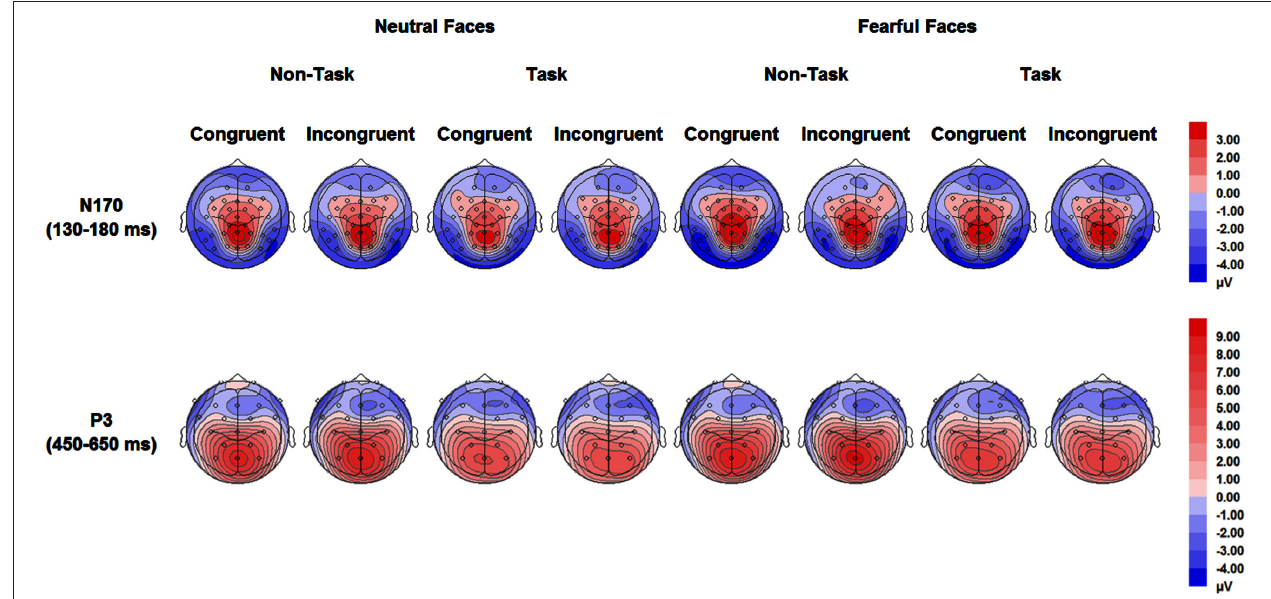
TABLE 4 | Mean of N170 amplitude ( µ V) and its SE for all the experimental conditions. Neutral faces Fearful faces Non-task Task Non-task Task M SE M SE M SE M SE Congruent − 2.92